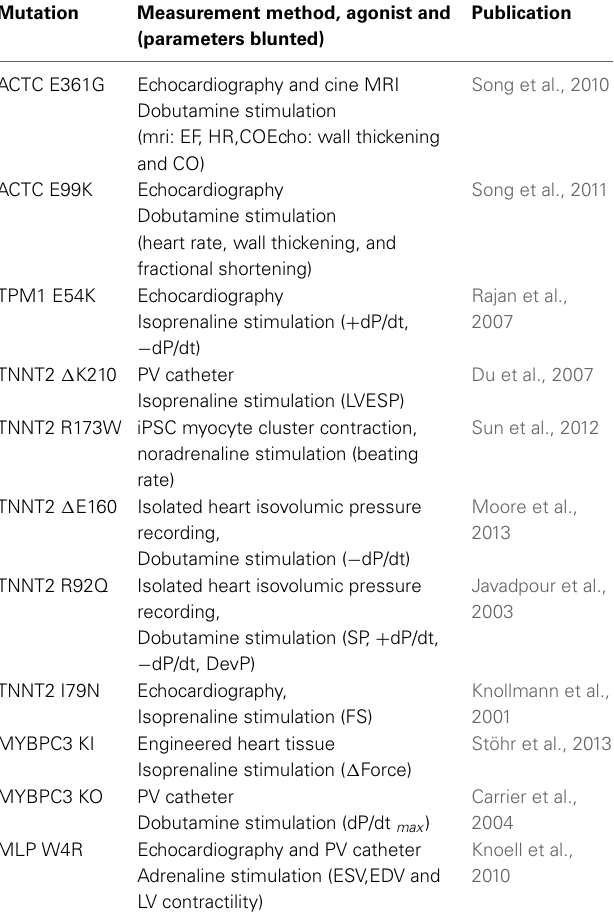
Table 2 | Mutations reported to blunt response to β